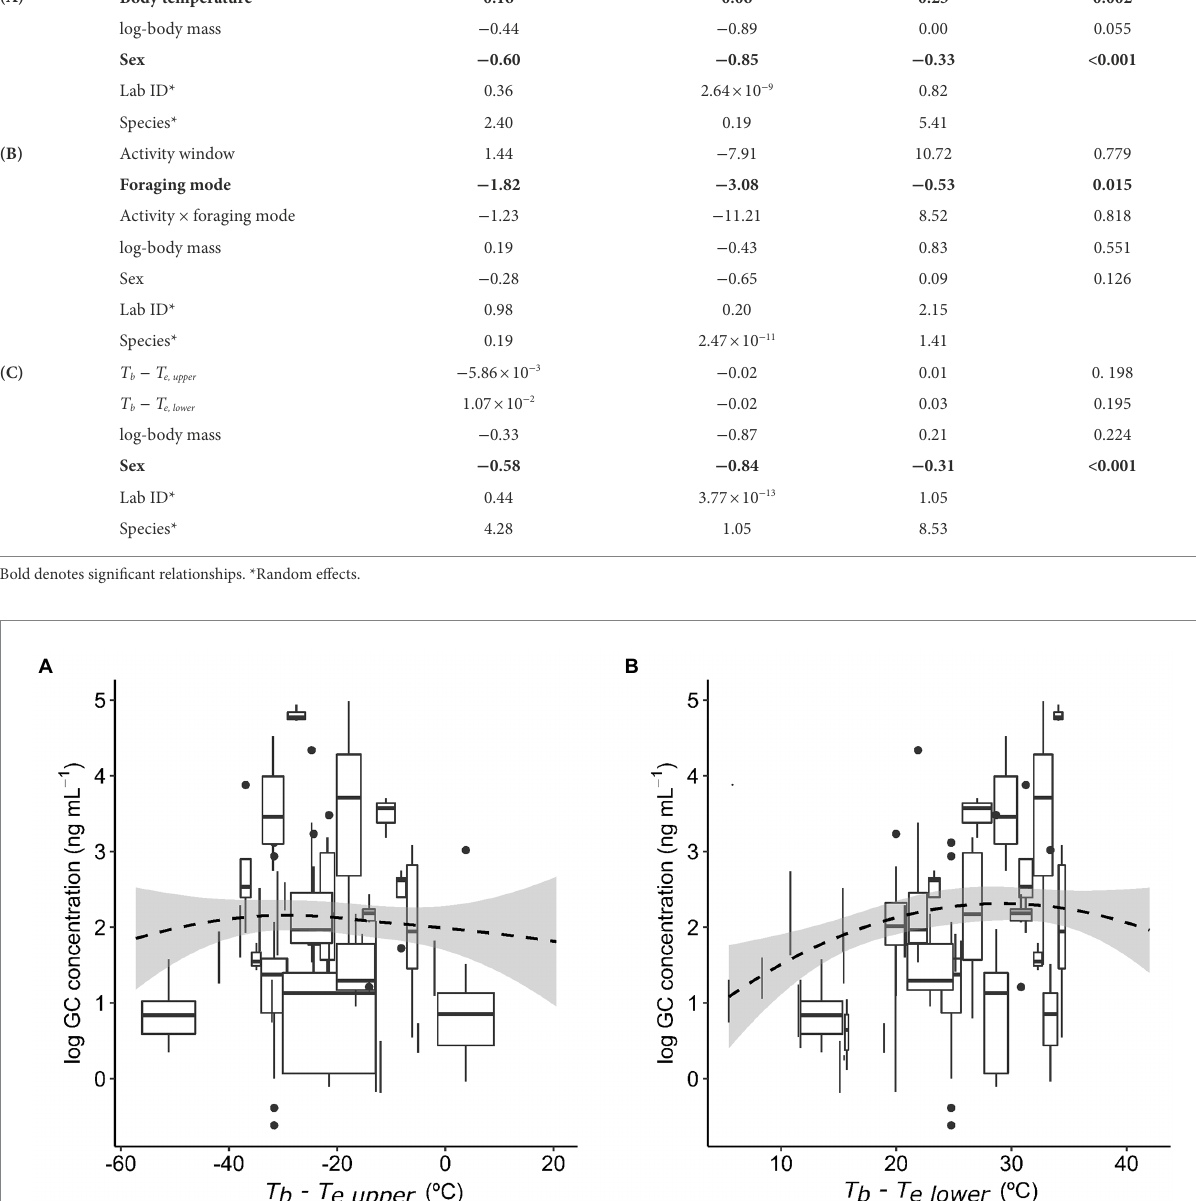
FIGURE 2 Baseline glucocorticoid (GC) concentrations in relation to the difference between field body temperature ( T b ) and upper range of operative temperatures ( T e upper ; 95% percentile, A ), and difference between field body temperature and lower range of operative temperatures ( T e lower ; 5%, B ). Boxes represent variation in GCs and operative temperatures for each species, where horizontal lines within boxes are median GC concentrations, box width captures the interquartile range in operative temperature, box height represents the interquartile range in GC concentrations, and whiskers show the range outside the lower an upper quartile. Smooth lines (dashed denotes nonsignificant relationships) are loess curves with span parameter of 2.